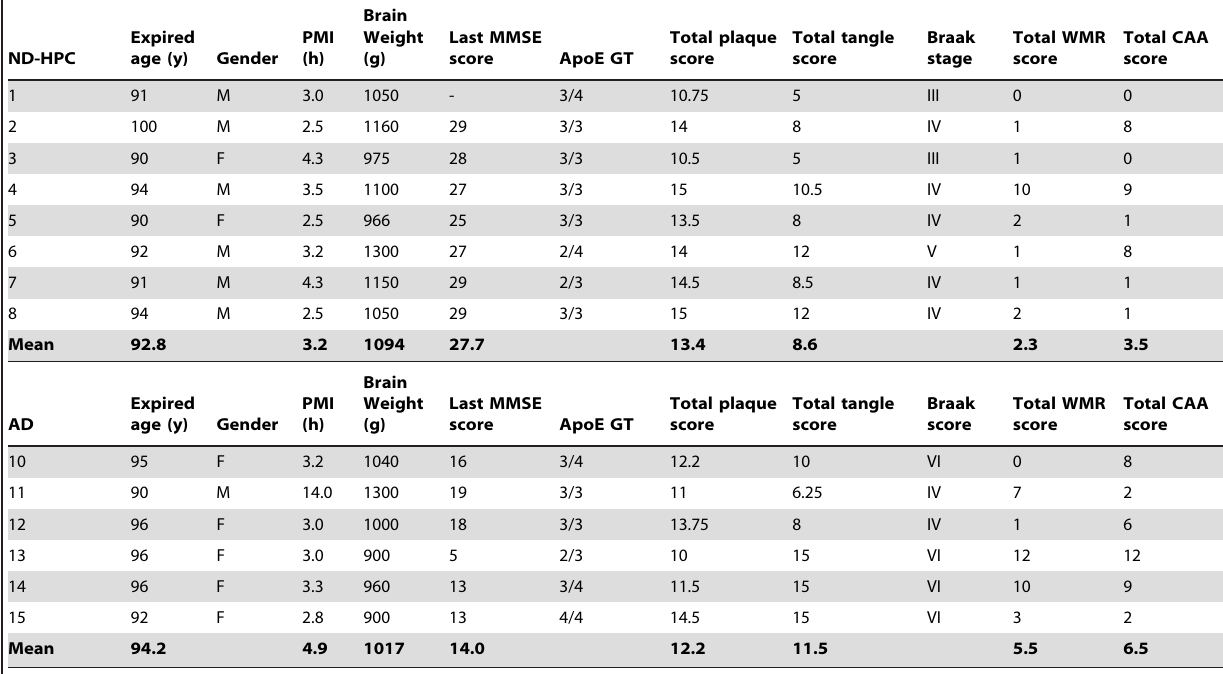
Table 1. Oldest-old BSHRI Study Subject